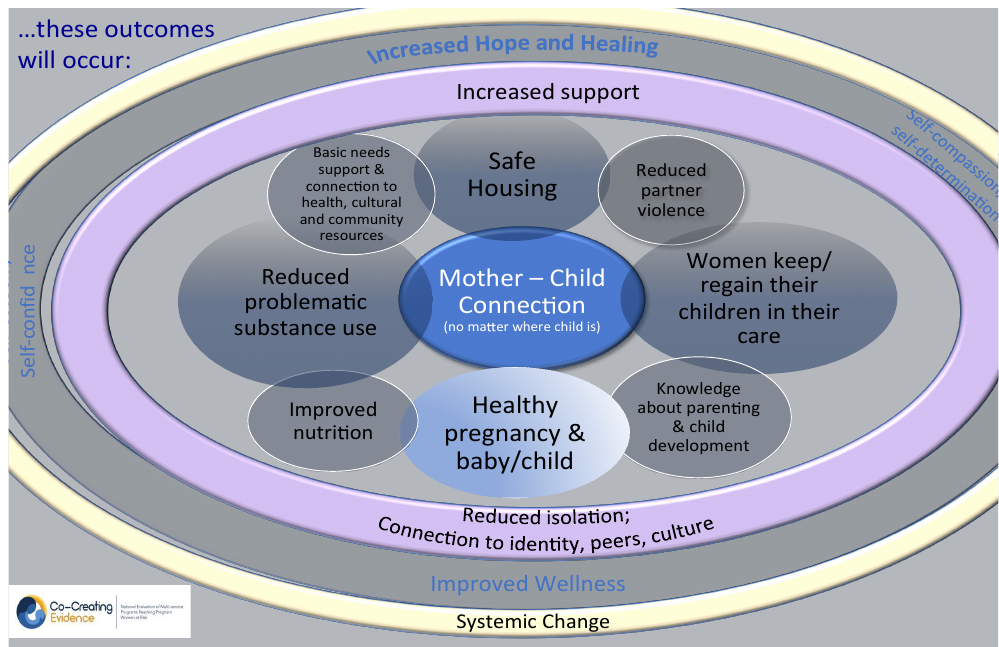
Figure 4. Anticipated outcomes of programs involved in the Co-Creating Evidence project.